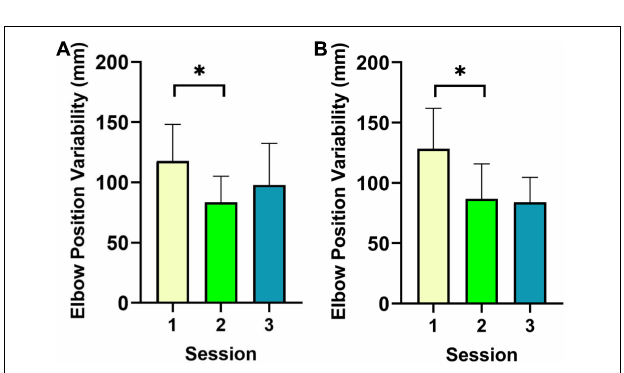
FIGURE 3 | Results for spatial variability of elbow movements are shown. Results for both elbows [i.e., left elbow (A) , right elbow (B) ] revealed reduced spatial variability between S1 and S2. *indicates significance at the Bonferroni corrected alpha